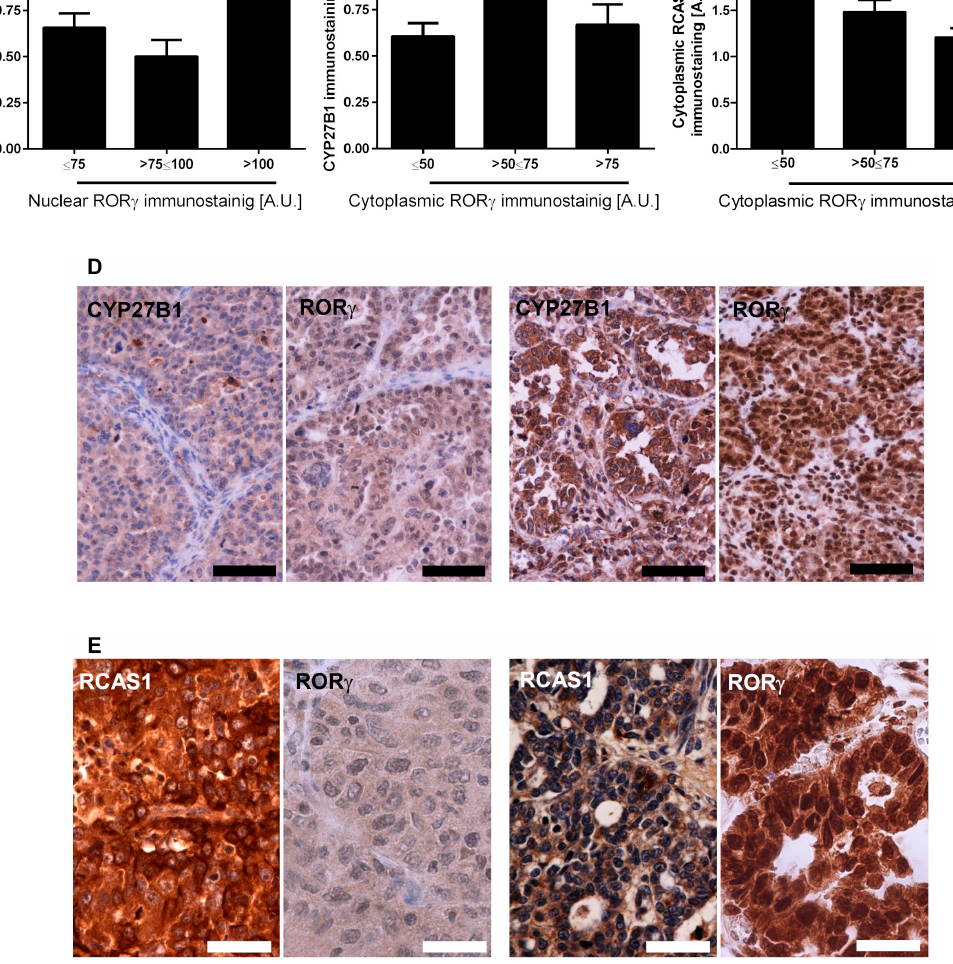
Figure 2. Correlation of nuclear ( A ) and cytoplasmic ( B , C ) ROR γ immunostaining to cytochrome P450 (CYP)27B1 ( A , B ) and RCAS1 (receptor binding cancer antigen expressed on SiSo cells) ( C ) expression in ovarian tumors ( n = 63). Statistically significant differences are denoted with asterisks as determined by ANOVA (black asterisks) or Student’s t -test (red asterisks, * p < 0.05, ** p < 0.01). ( D ) Representative images of CYP27B1 and ROR γ immunostaining of two ovarian cancer cases. ( E ) Representative images of RCAS1 and ROR γ immunostaining of two ovarian cancer cases. Scale bars: black = 50 μ m, white = 100 μ m.